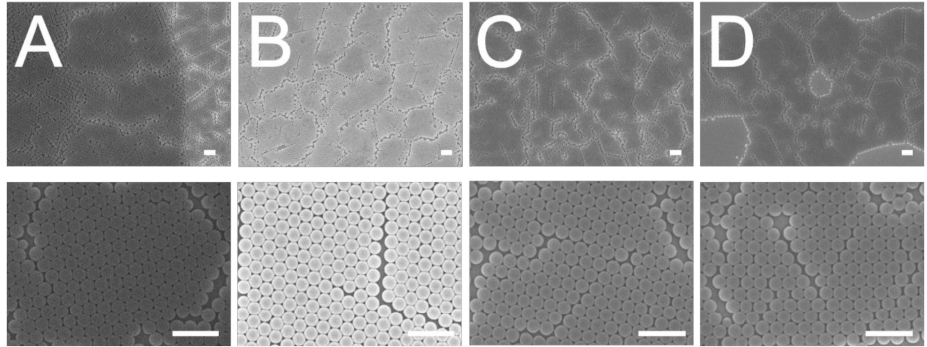
Figure 4. Influence of spin speed on the assembly of 300 nm nanosphere arrays, ( A ) 2000 rpm, ( B ) 3000 rpm, ( C ) 4000 rpm, ( D ) 5000 rpm (disperant percentage was 10% and spin time was 30 s. Scale bar: 1 µ m; Magnification: top—6000 × , bottom—25,000 ×